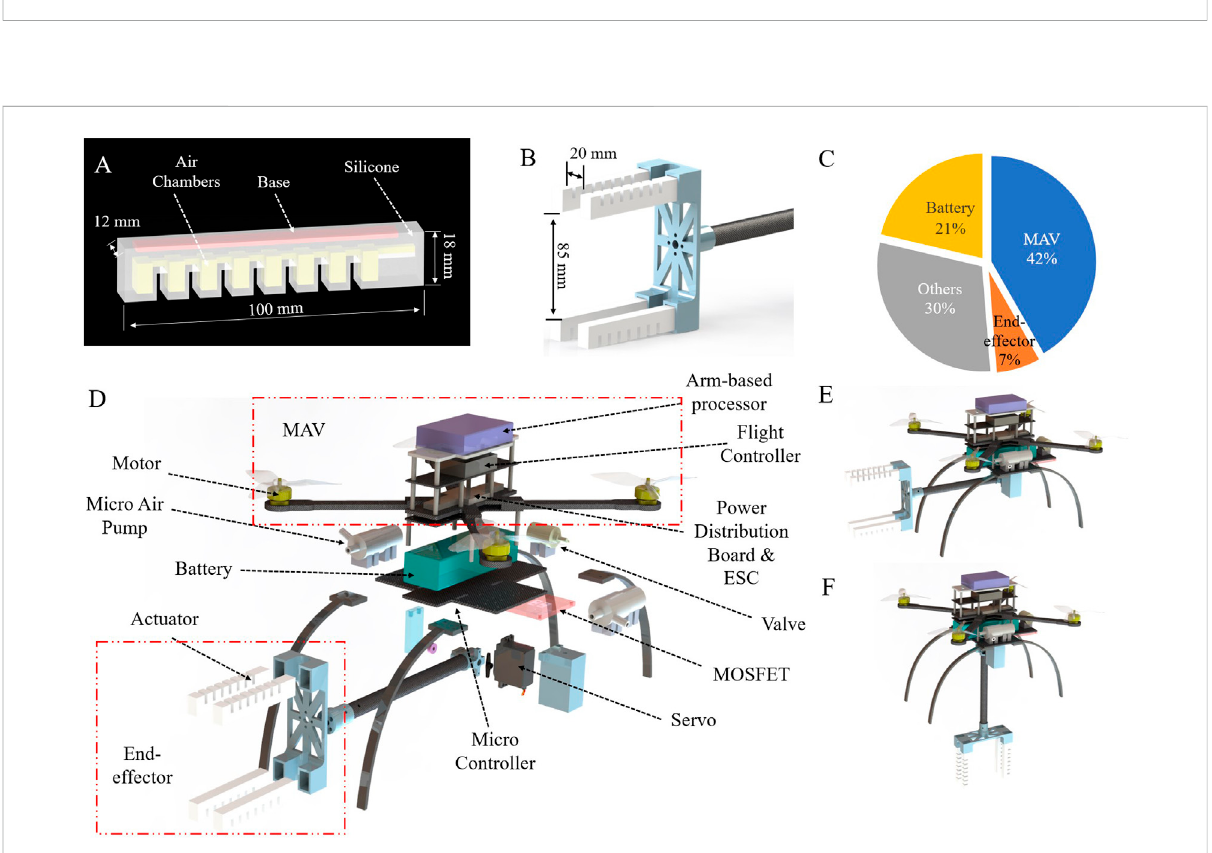
FIGURE 2 Detailsofthesystemdesign. (A) Actuatordesign. (B) End-effectordesign. (C) WeightdistributionoftheSoAGrobot. (D) Anexplodedviewofthe SoAG robot. (E,F) The robot with the arm up and